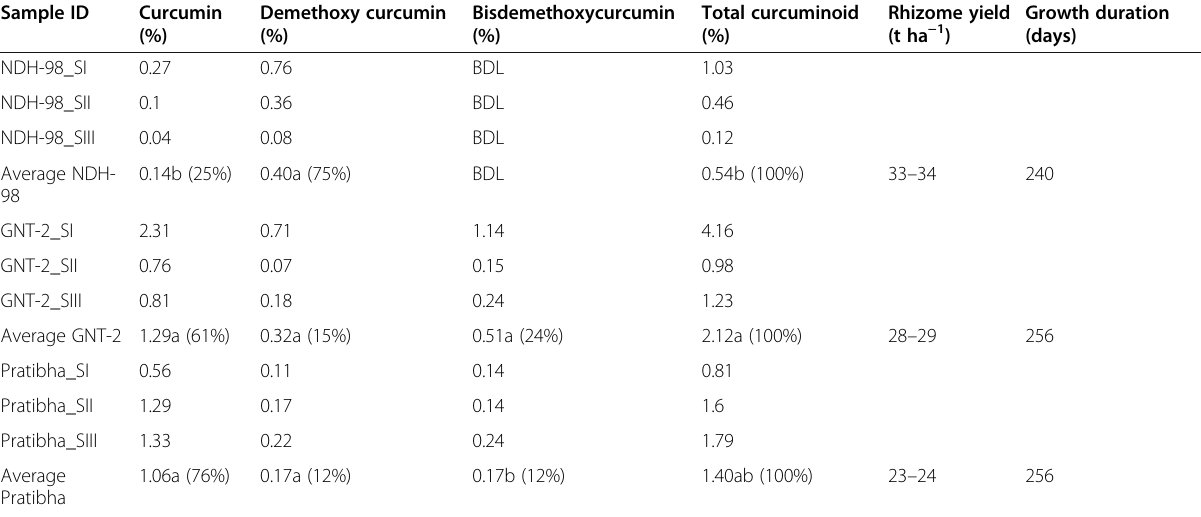
Table 1 Curcuminoid contents in turmeric cultivars at different stages under study Sample